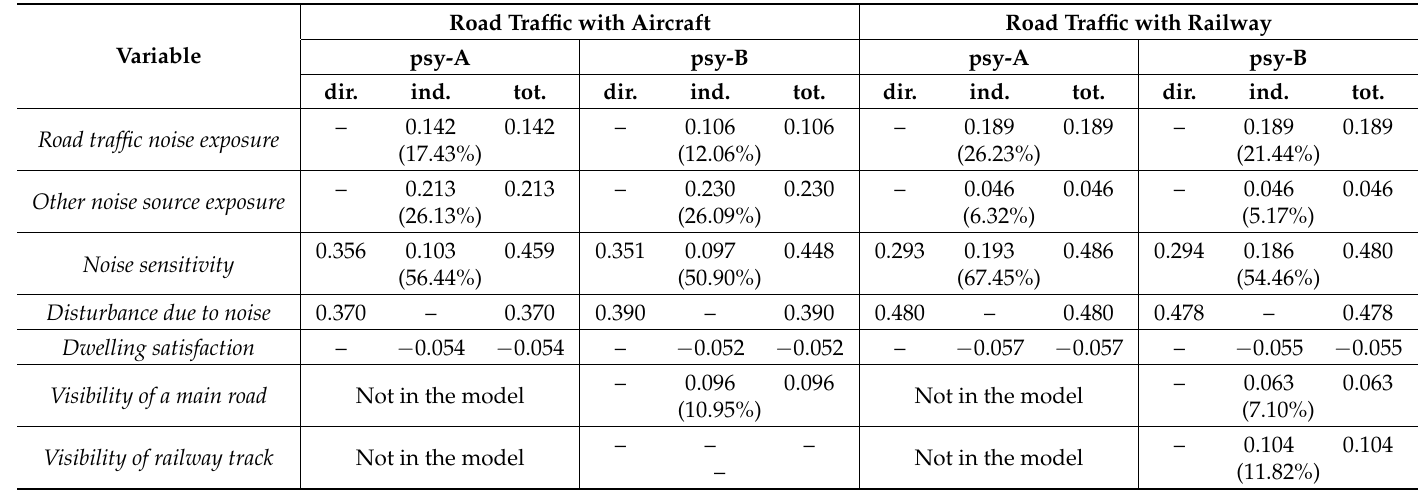
Table 10. Direct (dir.), indirect (ind.) and total (tot.) effects of all variables affecting Noise annoyance due to combined noises in psychophysical Models psy-A and psy-B. Contributions of exogenous variables are given in percentage between